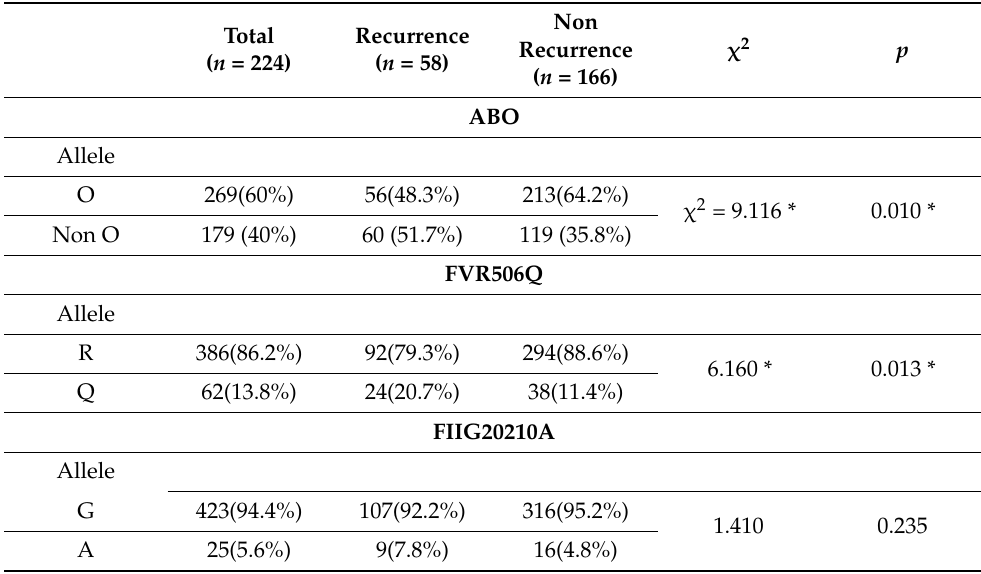
Table 3. Risk allele frequency of the five SNPs among the two studied groups of